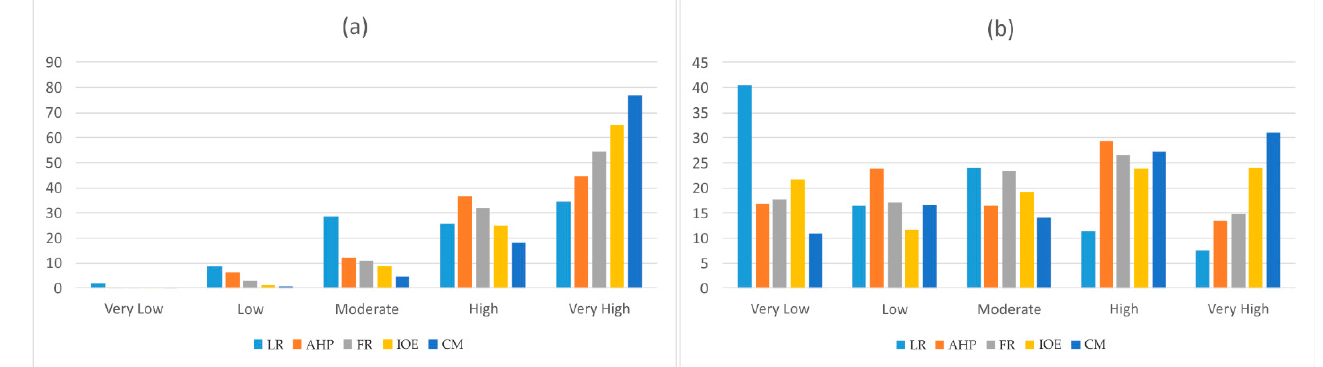
Figure 12. ( a ) Landslide susceptibility distribution of five classes in landslide inventory, ( b ) Landslide susceptibility distribution of five classes for whole study area. Table 7. Percentages of susceptibility classes according to the method used.